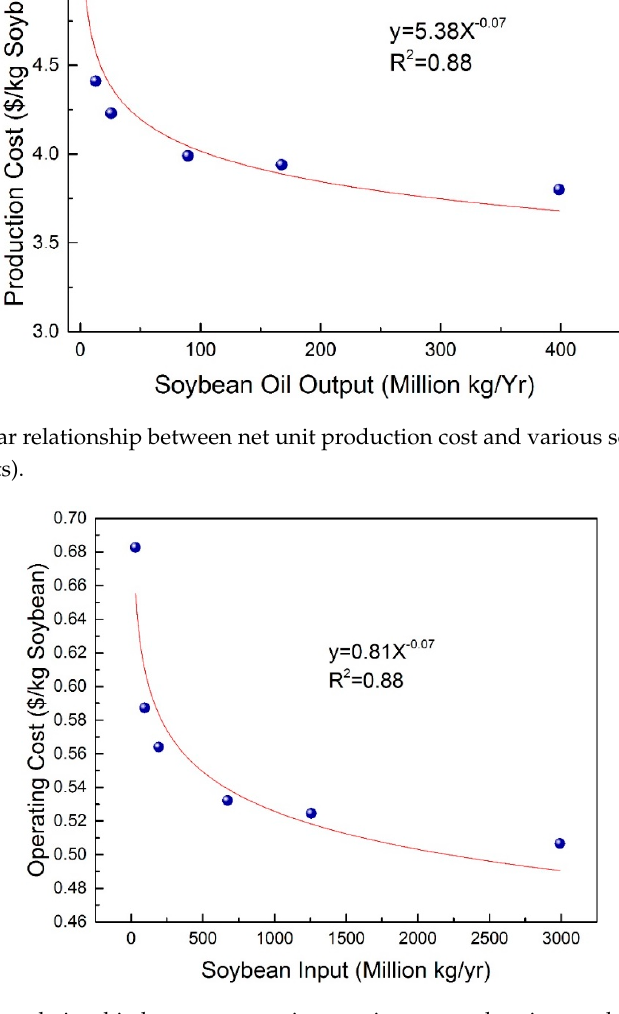
Figure 7. Non-linear relationship between net unit operating cost and various scales of soybean inputs (i.e., processing capacities). (i.e., processing